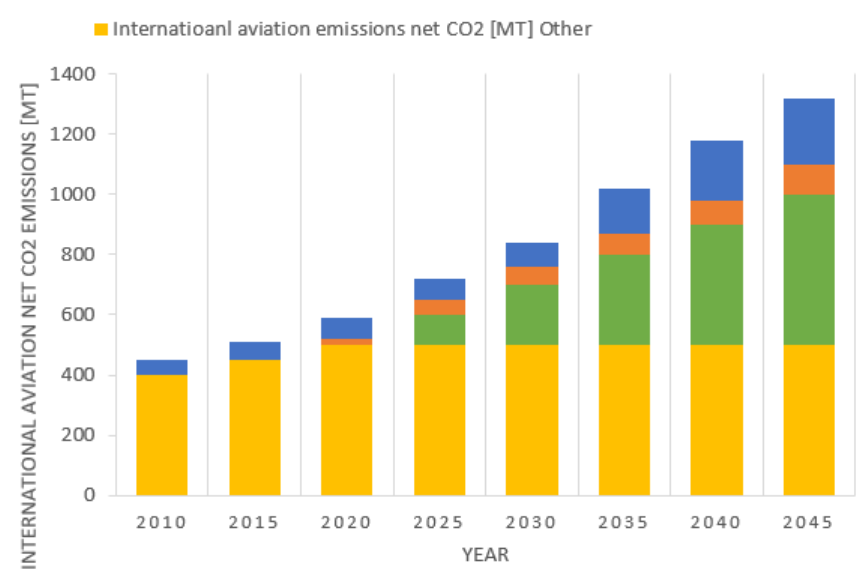
Figure 1. The contribution of different measures for reducing aviation CO 2 emissions [3].